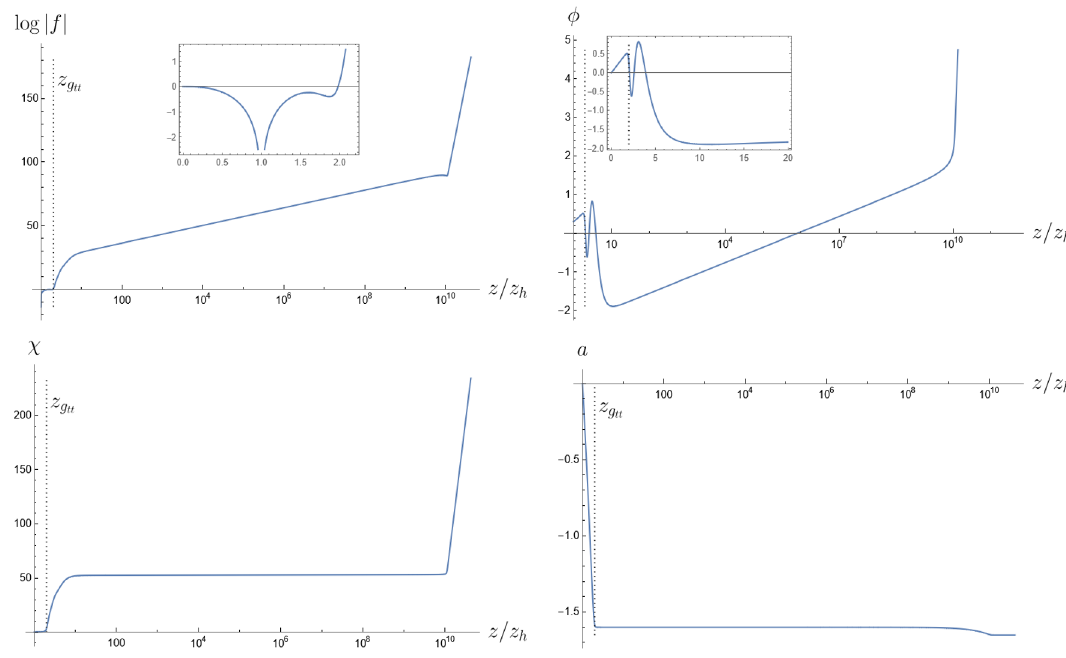
Figure 8 . Sample solution for the charged case, with a single Kasner inversion. For illustration purposes, we have chosen the values ρ = 2 , φ h = 0 . 3 , z h = 1 , q = 1 and χ h = 0 . 1 . The vertical dotted line is the “would be” Cauchy horizon z g . tt